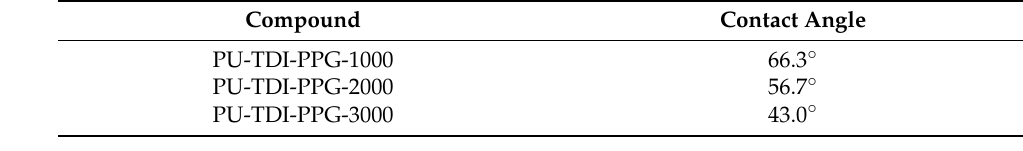
Table 8. Contact angle data of polyurethanes.